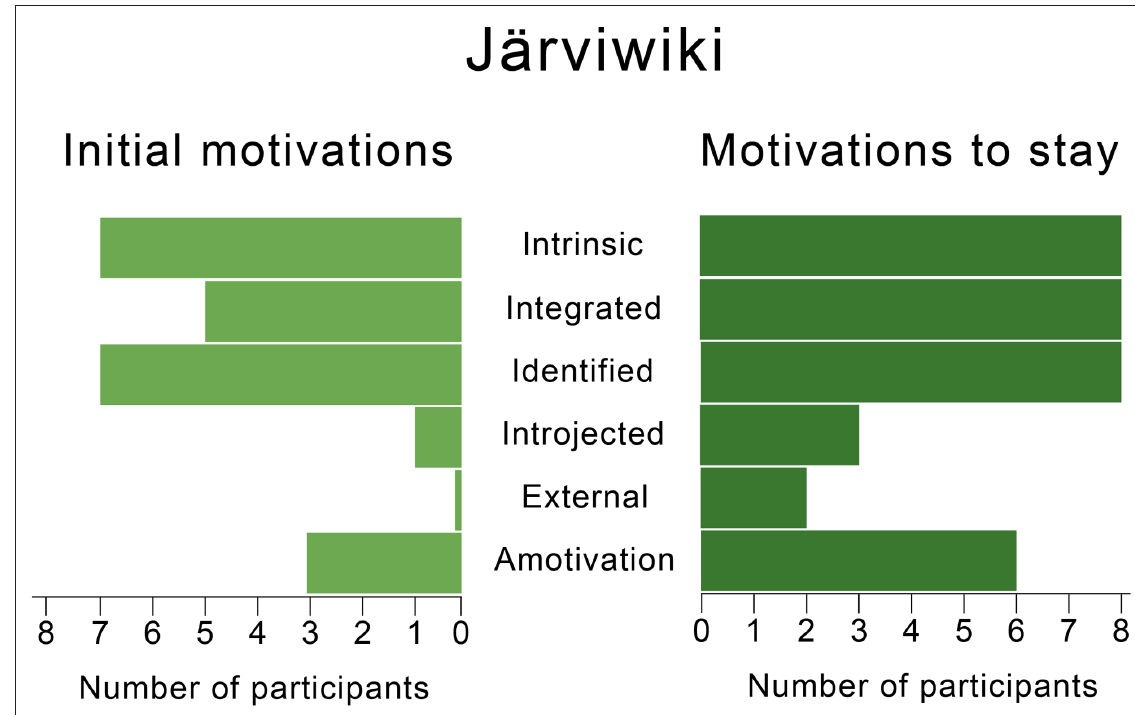
Figure 6: Values underlying participation among Järviwiki participants.